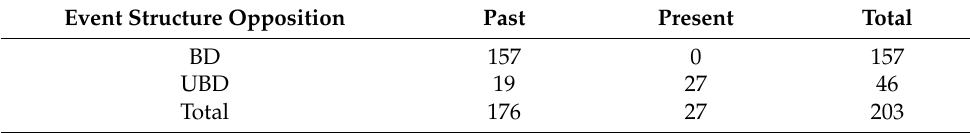
Table 11. Temporal anchoring of BD vs. UBD utterances in all temporal contexts. Event Structure